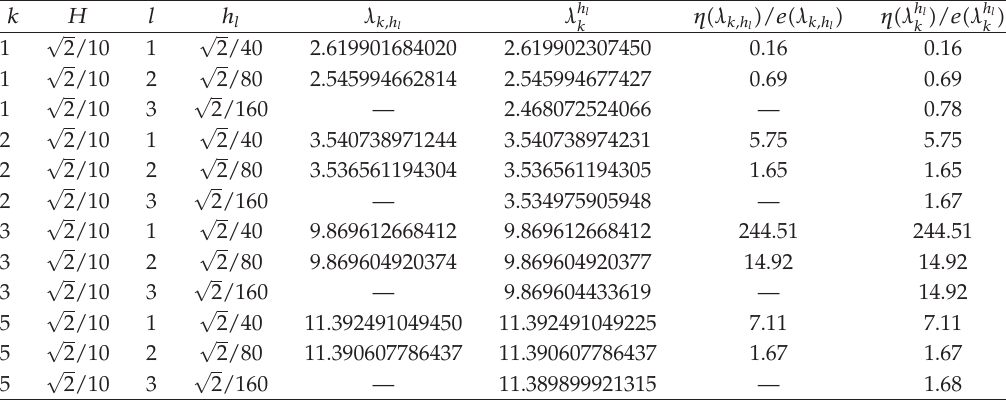
Table 2: The results on the L-shaped domain by Scheme 1 (cid:3) P 2 - P 1 element (cid:6) for the eigenvalue problem of electric field (cid:3) r (cid:8) 0 . 5 (cid:6) .